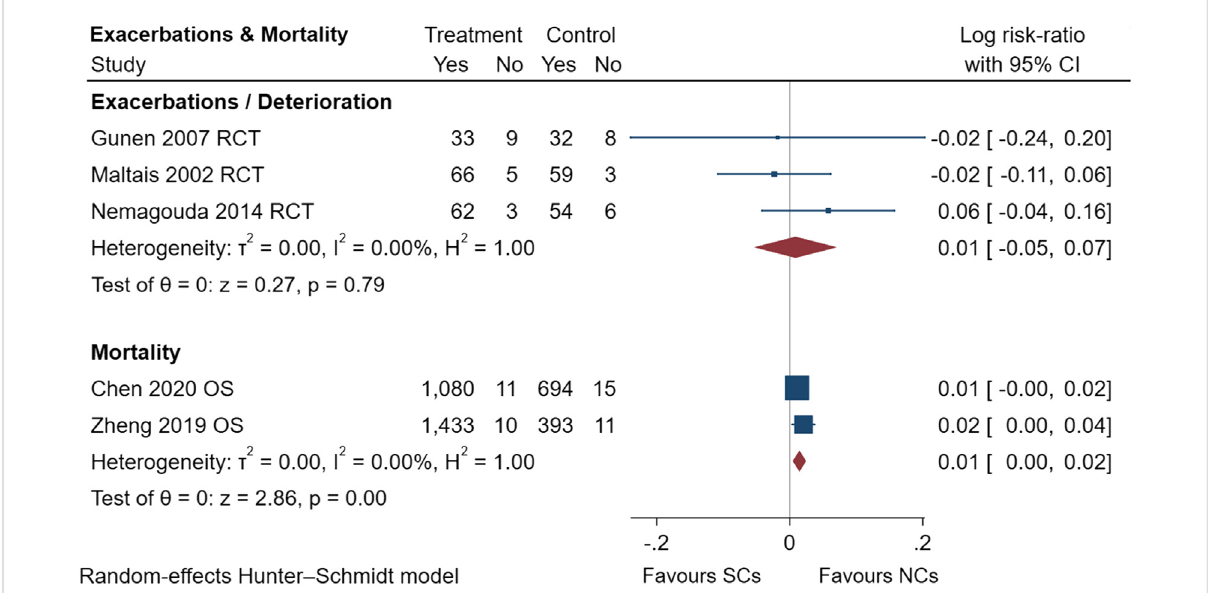
Exacerbations and mortality of SCs and NCs in observational studies and randomized controlled